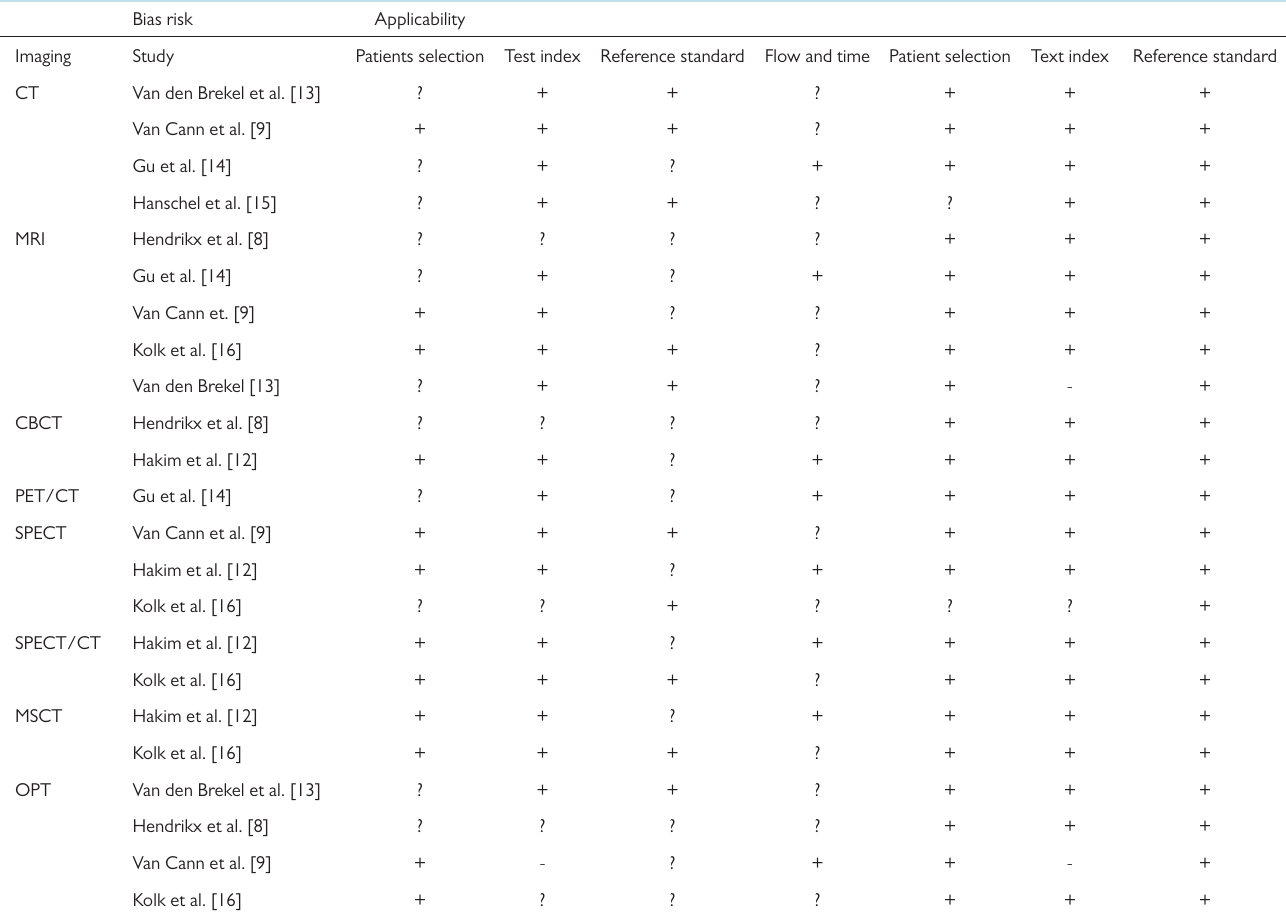
Table 5. Methodological quality established according to each QUADAS-2 domain for each single study Bias